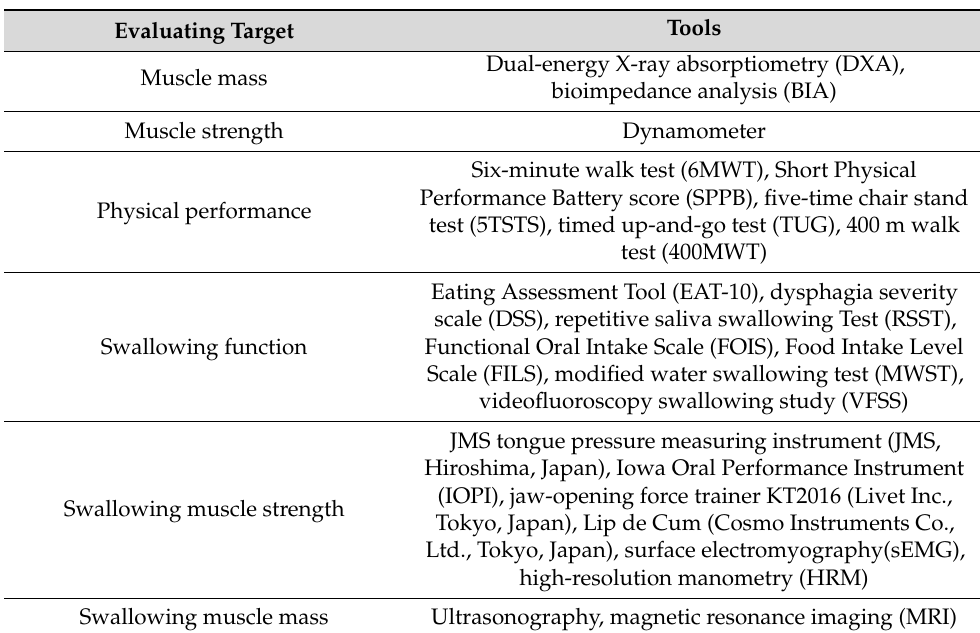
Table 2. The tools for assessing sarcopenic